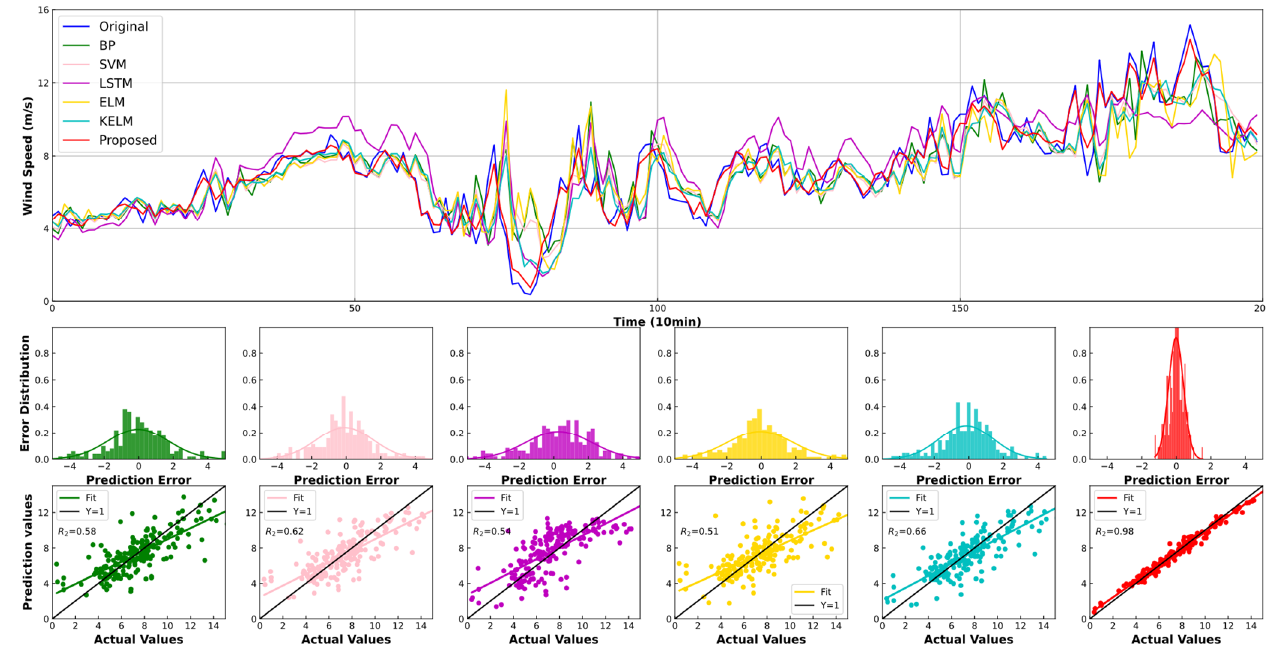
Figure 3. The results of each prediction model in two-step prediction in SH Apr.